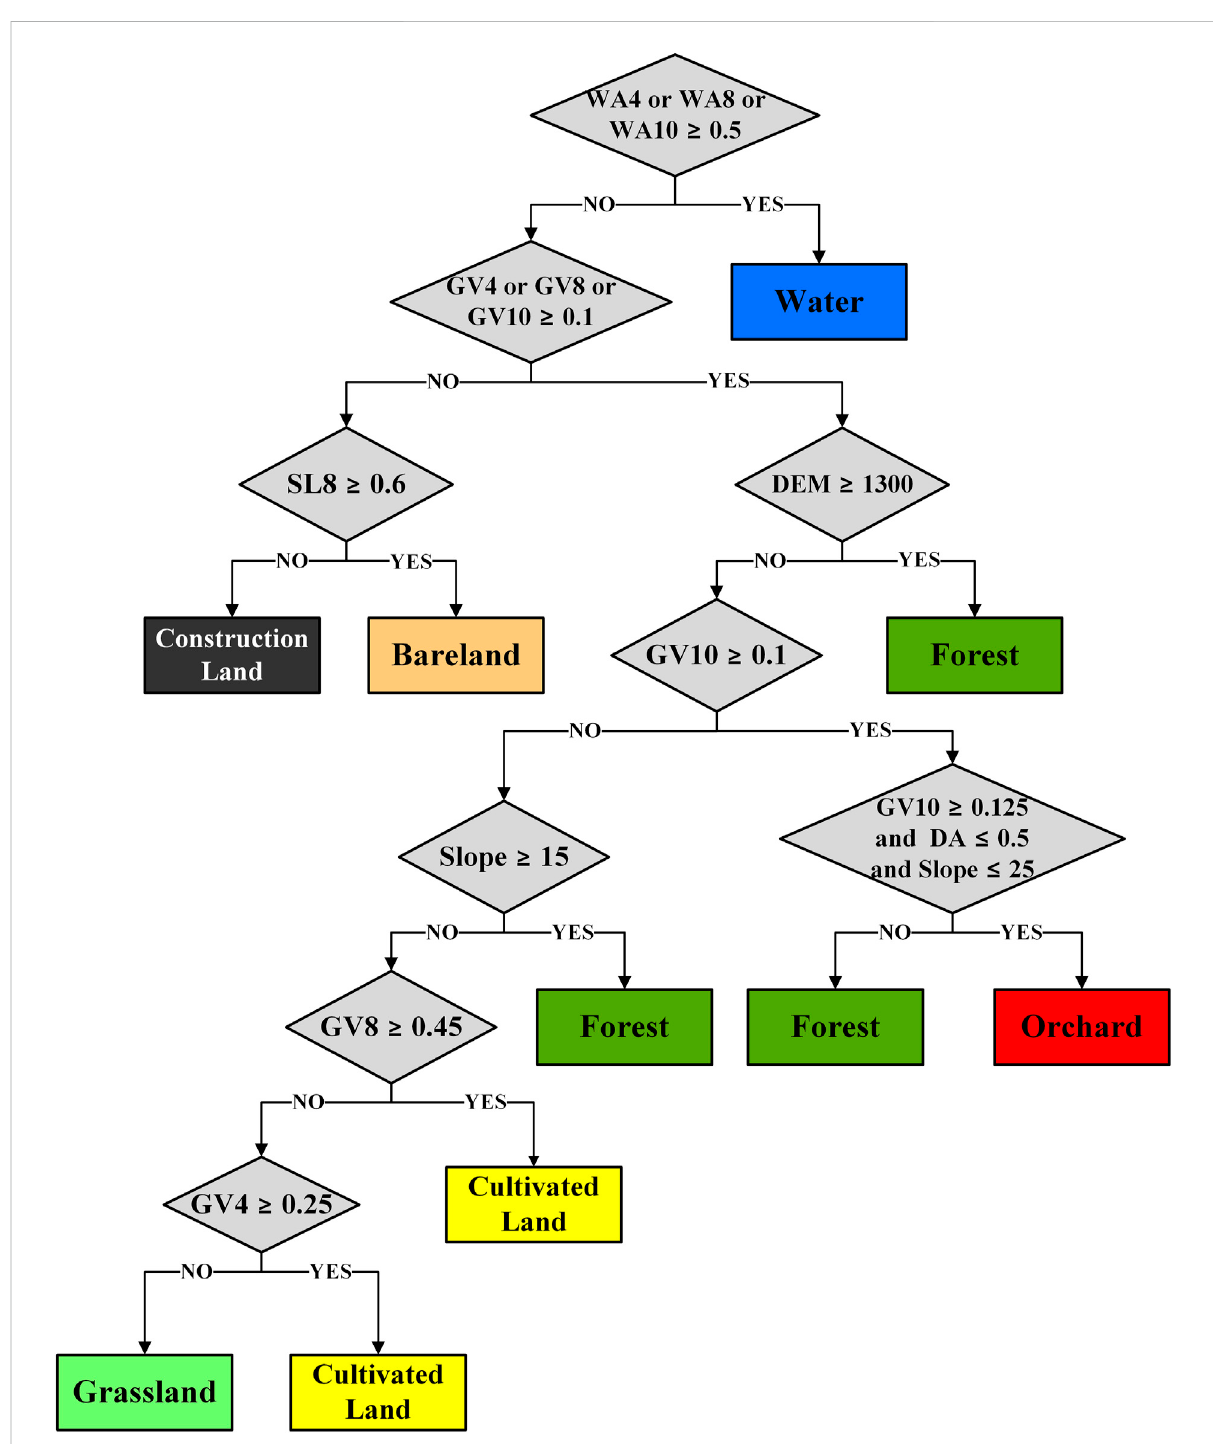
FIGURE 4 The land use/cover classi fi cation decision tree in this